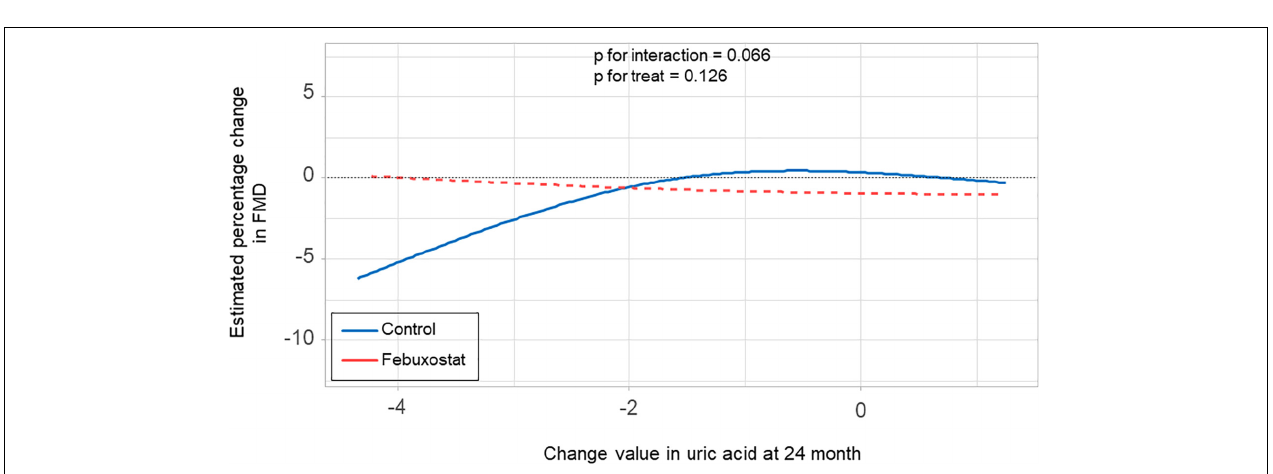
FIGURE 4 | Relationship between estimated percentage change in flow-mediated vasodilation (FMD) and serum uric acid levels at 24 months in the febuxostat group and the control group adjusted for baseline FMD.